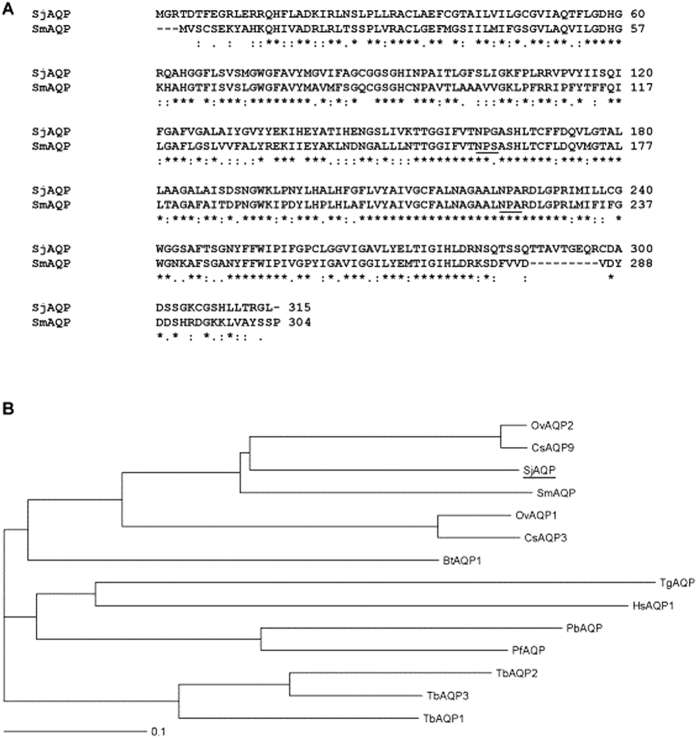
Deduced primary protein sequence and phylogenetic analysis of SjAQP.(A) Deduced amino acid sequence of SjAQP and alignment with its homolog SmAQP from Schistosoma mansoni. Asterisks indicate fully conserved residues; colons indicate strongly conserved similar residues with scores >0.5 in the Gonnet PAM 250 matrix; and periods indicate weakly similar residues with scores ≤0.5 in the matrix. The two highly conserved loops of the AQP family are underlined. (B) Phylogenetic analysis of SjAQP and characterized homologs from Homo sapiens (HsAQP1), Bos taurus (BtAQP1), Plasmodium berghei (PbAQP), Plasmodium falciparum (PfAQP), Opisthorchis viverrini (OvAQP), Clonorchis sinensis (CsAQP), Toxoplasma gondii (TgAQP), and Trypanosome brucei (TbAQP). Unit, 0.1 amino acid substitutions per site.